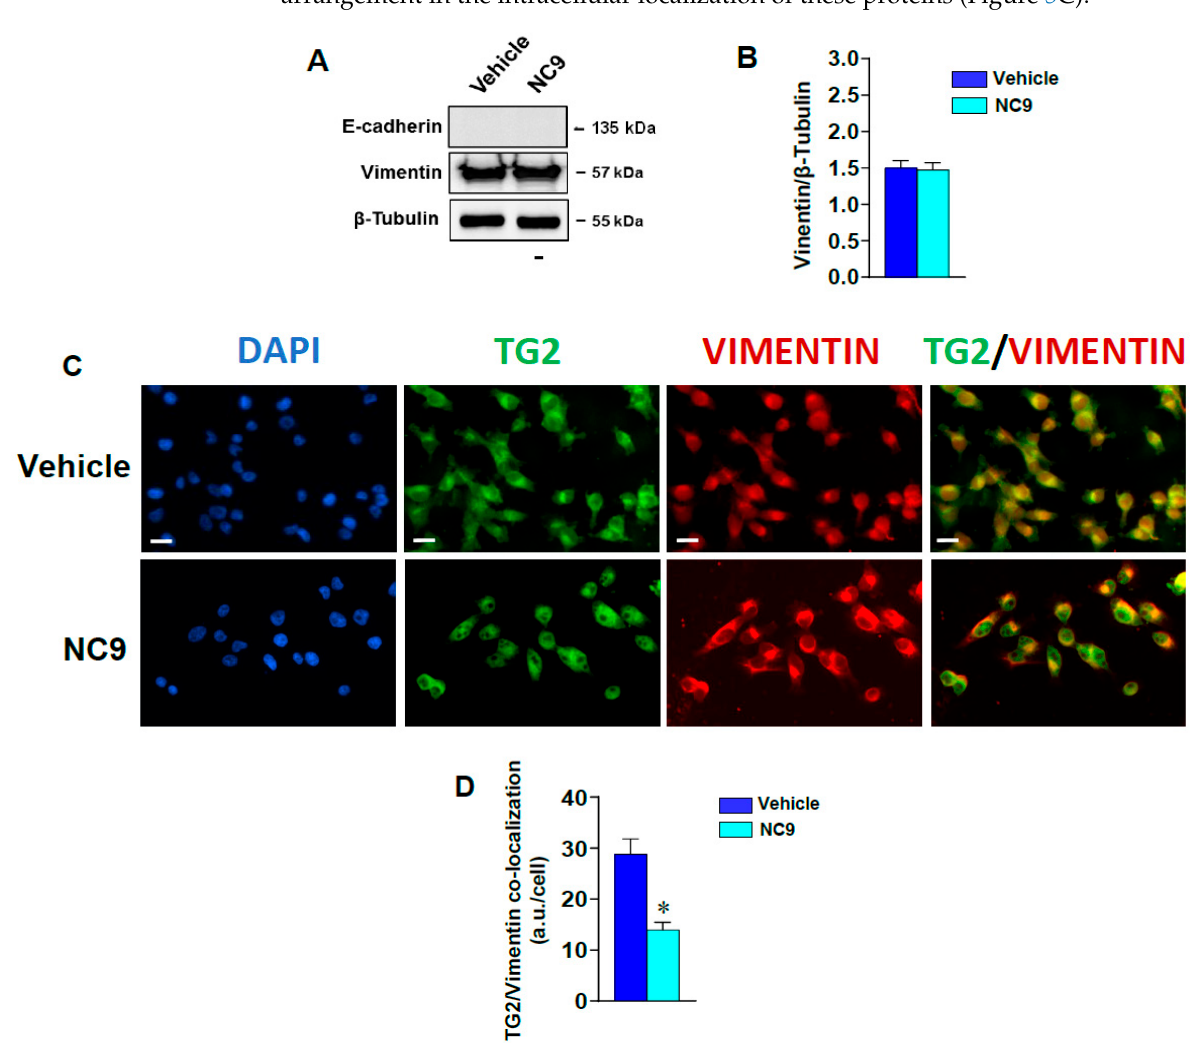
Figure 5. ( A ) Representative immunoblot analysis of E-cadherin and vimentin on total lysates from MDA-MB-231 cells grown in the presence of vehicle or NC9. ( B ) Levels of proteins deduced from the analysis of chemiluminescence. β -Tubulin was used as internal control for equivalence of proteins load. ( C ) Representative fluorescence images of MDA-MB-231 cells grown on glass dishes in the presence of vehicle or of NC9 and subjected to analysis of both TG2 and vimentin with a FITC- and a TRITC-coupled antibodies, respectively. DAPI data were also reported. Bar = 50 µ m. ( D ) Fluorescence intensity of the TG2/vimentin merged staining (yellow) calculated by the ImageJ software and reported as arbitrary units for cell (a.u./cell) ± SD. * p <0.05 versus